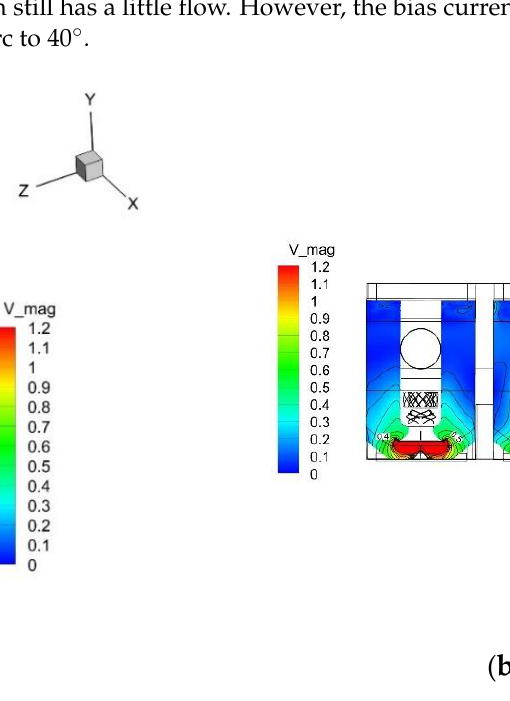
Figure 15. Plan 7 Isogram of velocity. ( a ) Center section of pump body along flow direction. ( b ) Center section of pump body in vertical flow direction.